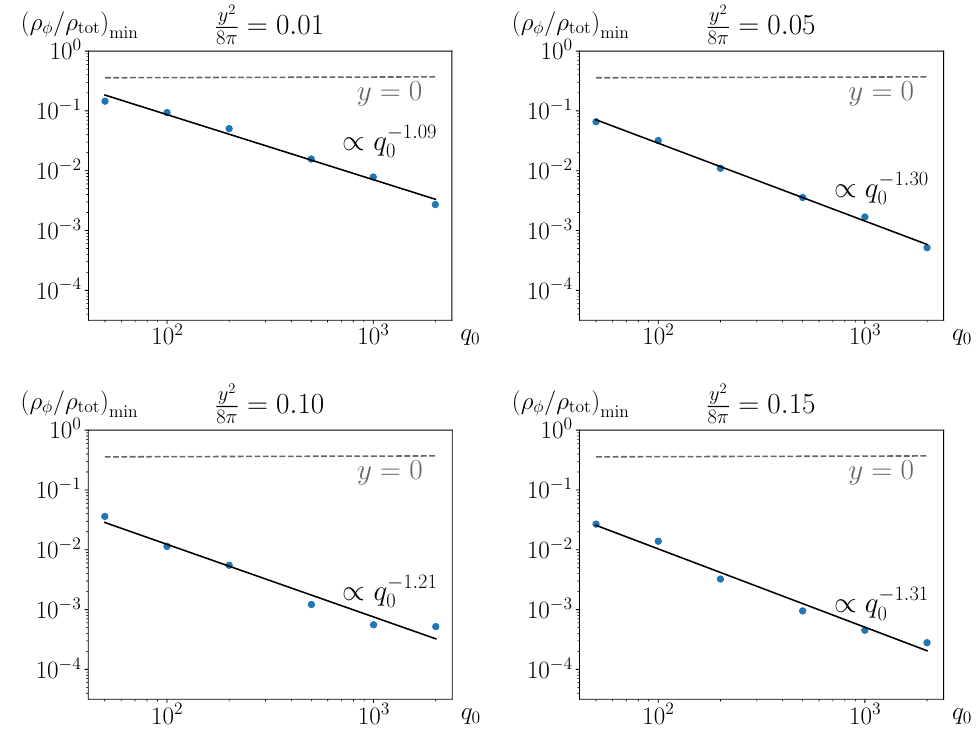
Figure 4. ( ρ φ /ρ tot ) min as a function of q 0 for different choices of y . The blue points are the simulation results, and the black line is the best fit with a power law ∝ q x in dashed gray the power law best fit for the y = 0 case, which is flat at ( ρ b = 0 . 9 , m = 10 − 6 M pl and Φ 0 = f = M pl